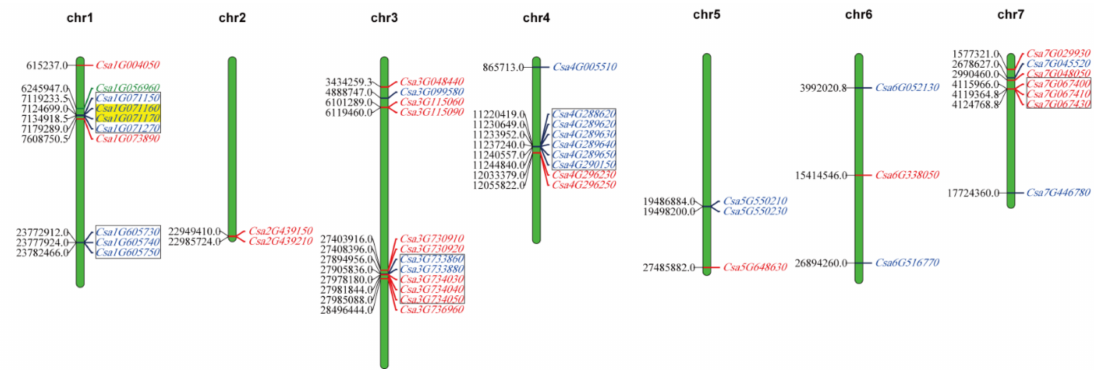
Figure 4. Chromosomal distribution and gene duplications of CsLecRLK genes. The number on the chromosome (left) represents the position of CsLecRLK genes, and the information on the chromosome (right) represents the gene ID of the CsLecRLK s. The tandem duplicated genes are represented by a yellow background, and the gene clusters are boxed together by black lines. The red represents L-type CsLecRLK s, the green represents C-type CsLecRLK s and the blue represents G-type CsLecRLK